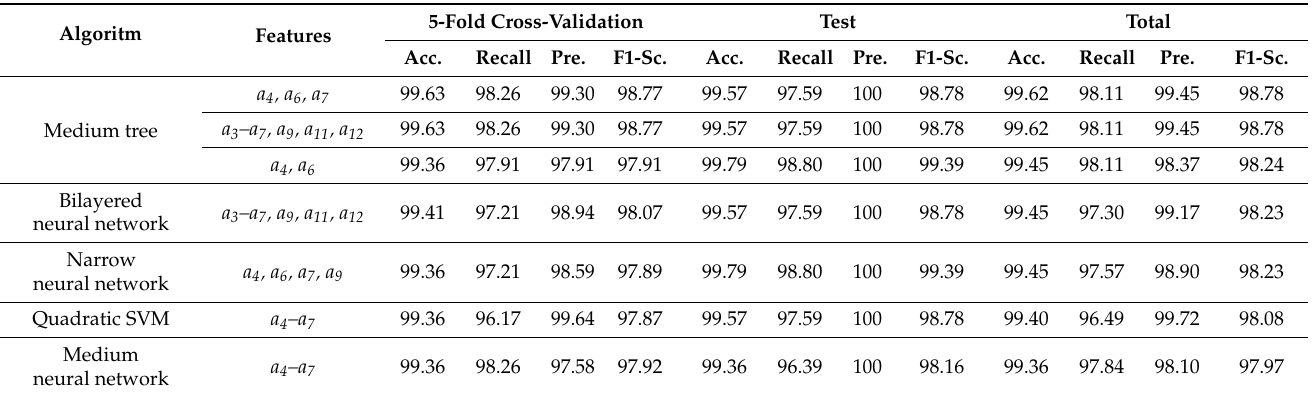
Table 5. The seven models that obtained the best results for leak detection in balloon-type cavities. Results are expressed as percentages.